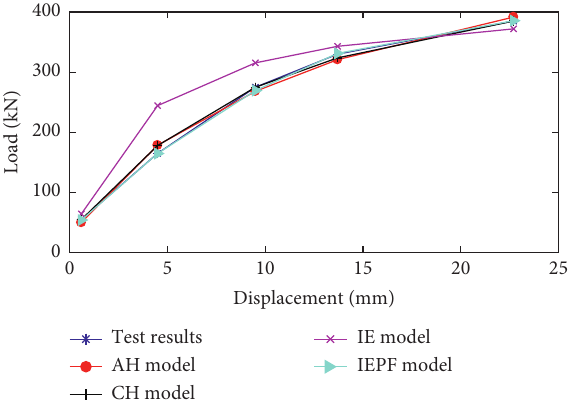
Table 12: Model parameters for example 3. 1 .